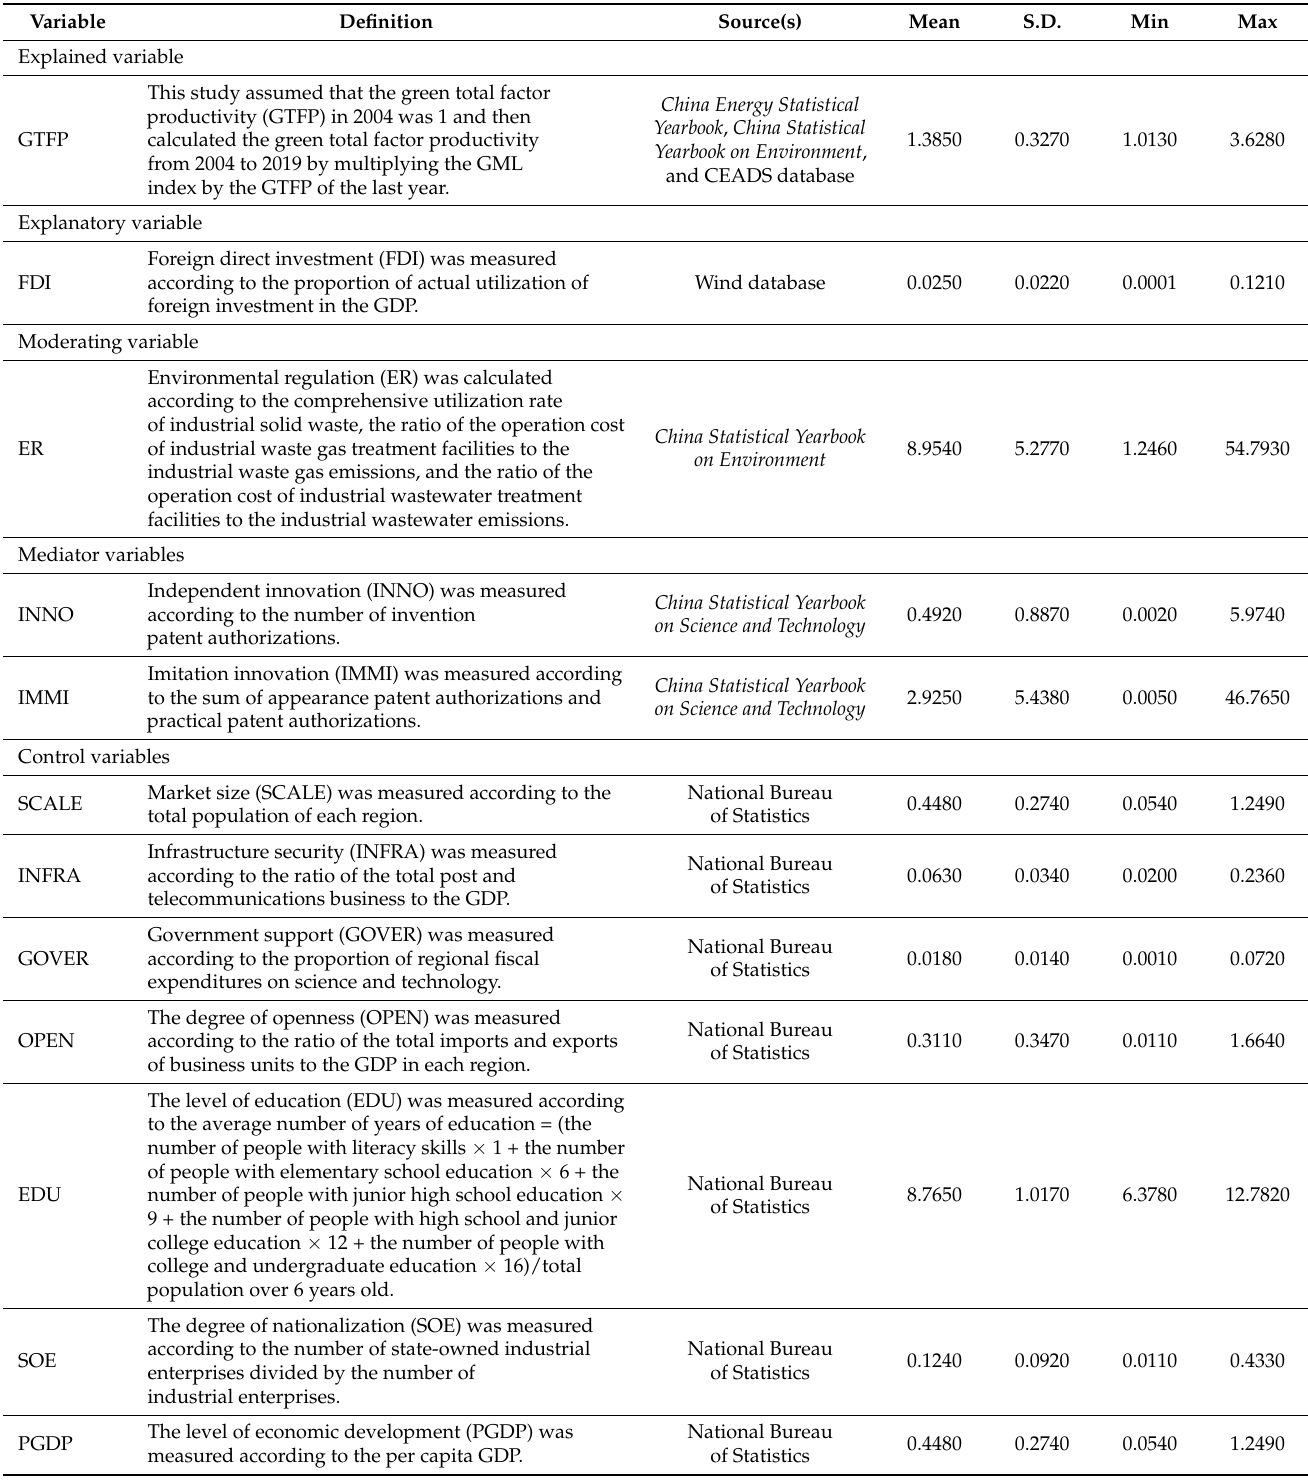
Table 2. The list of variables and data